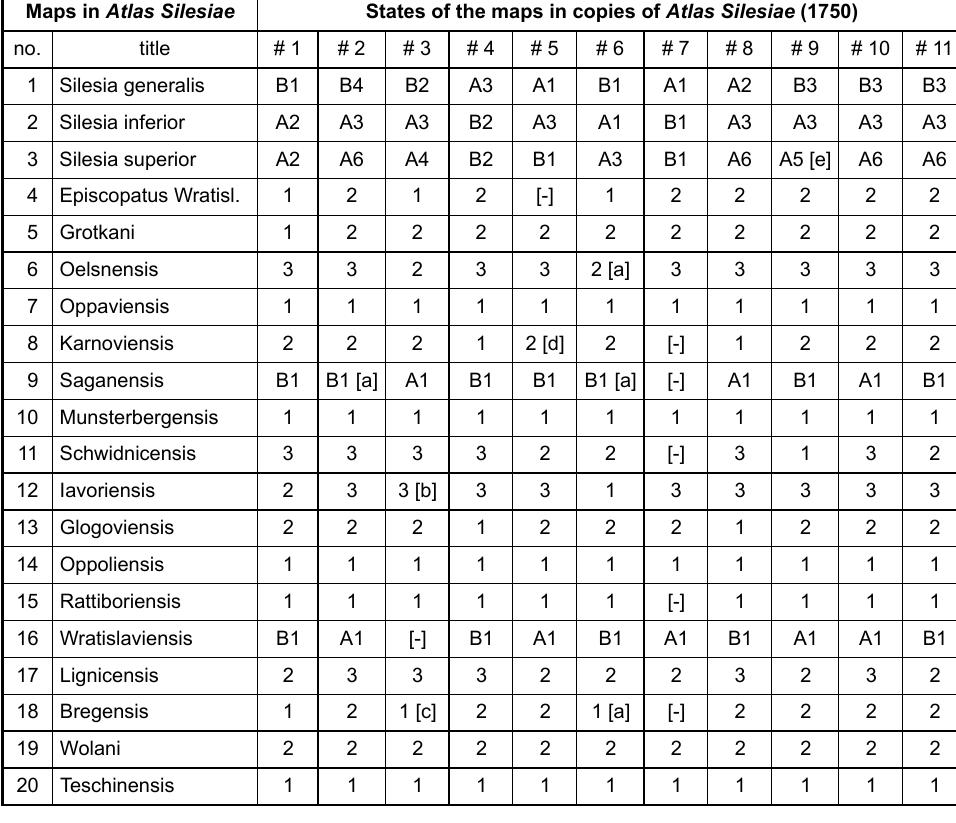
Table 4. States of maps in copies of Atlas Silesiae